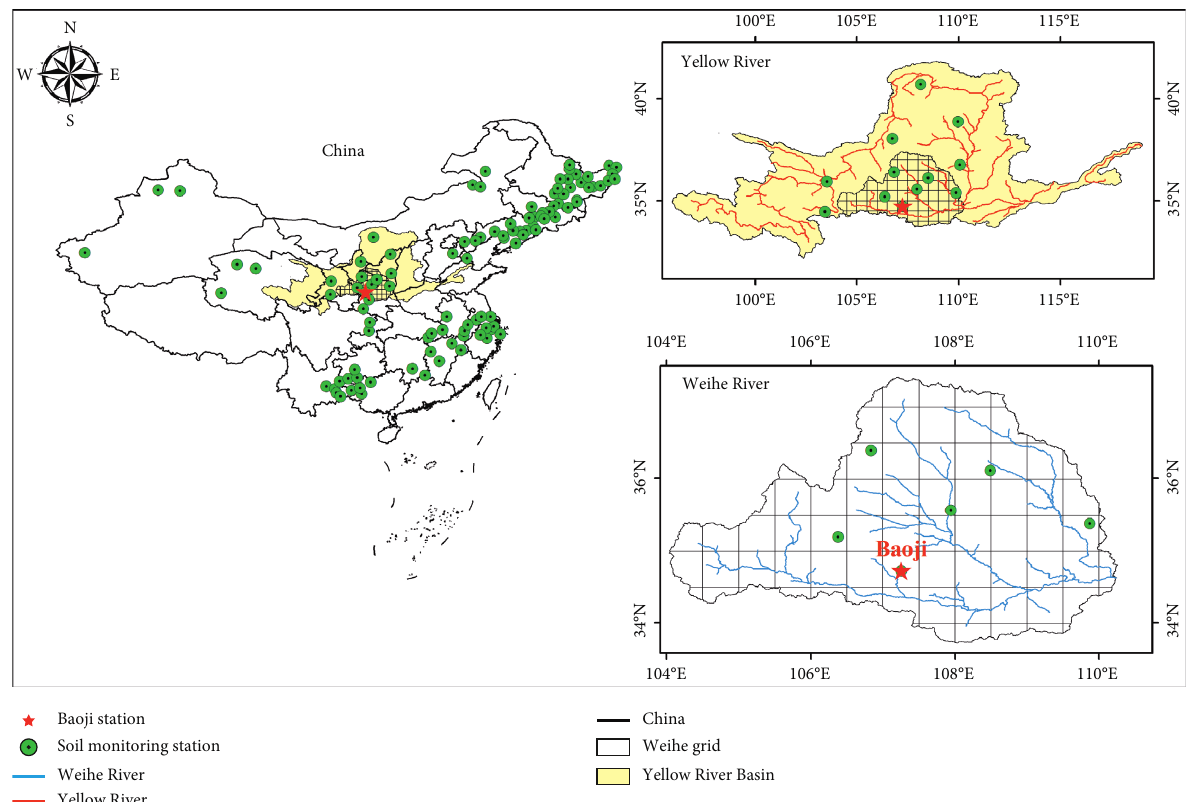
Figure 3: The distribution of soil monitoring stations in China and the location of the Baoji monitoring